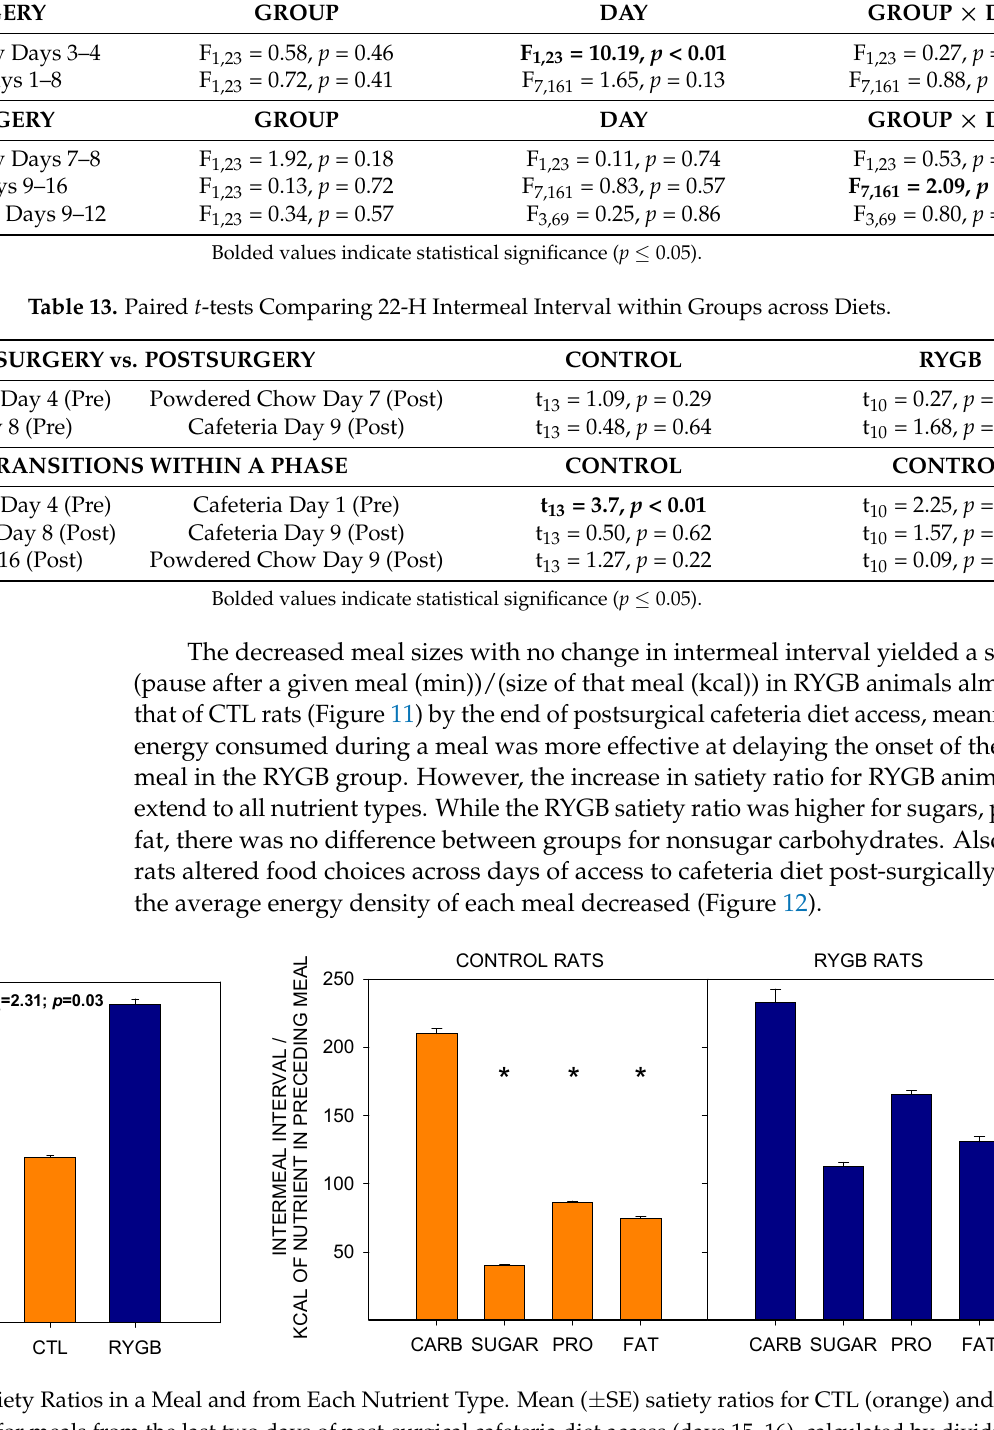
Table 12. Two-way ANOVAs Comparing 22-H Intermeal Interval between Groups for Each Diet Condition.